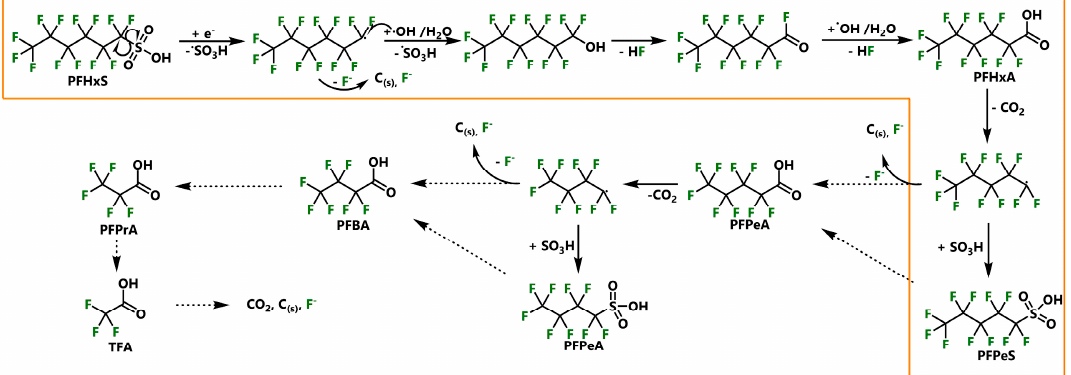
Figure 7. Decomposition of PFHxS via mechanochemical reaction with ferrate VI and zero-valent iron (ZVI), proposed by [128].